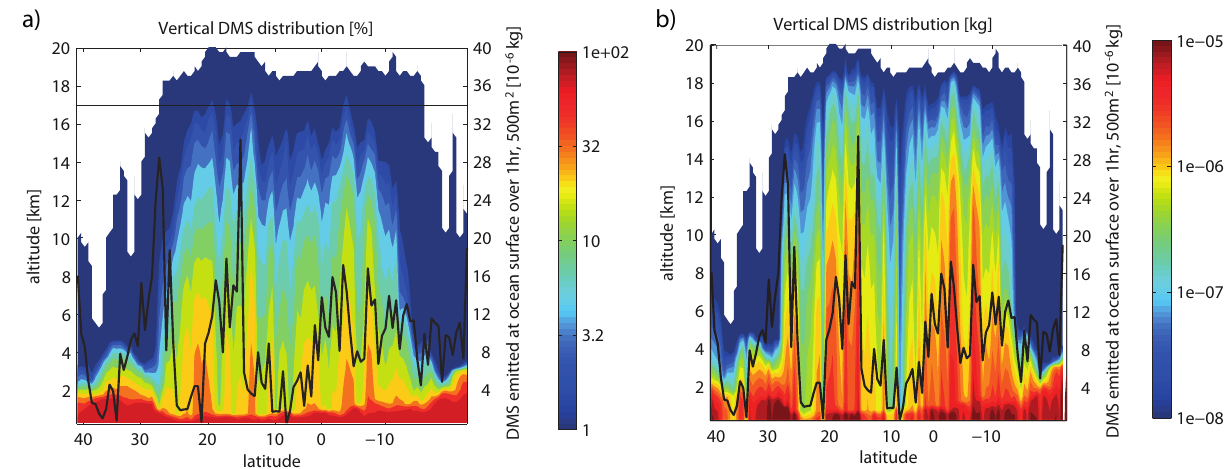
Fig. 2. Atmospheric vertical DMS distribution computed along the TransBrom cruise track given as (a) amount relative to DMS emission from the sea surface [%] and (b) total amount [kg]. Atmospheric DMS distribution is based on FLEXPART simulations with a 1 / 2 day atmospheric lifetime. DMS emission at the ocean surface over 500m 2 and one hour is given as the black line corresponding to the right y